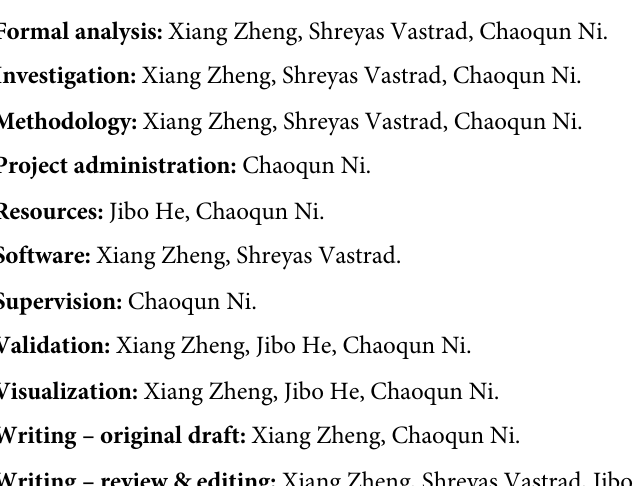
S2 Table. Topics in five- and one-star reviews and statistics of their probabilities. Represen- tative sentences have been replaced with gender-neutral pronouns. (A) five-star reviews. (B) one-star